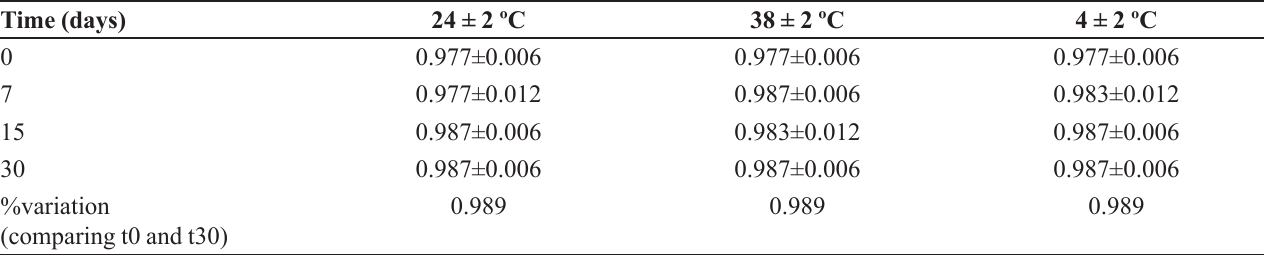
TABLE IV - Relative density values (g/cm 3 ) measured periodically, for 30 days, for the base formulation (mean ± standard deviation). The percentage of variation comparing t0 and t30 is shown